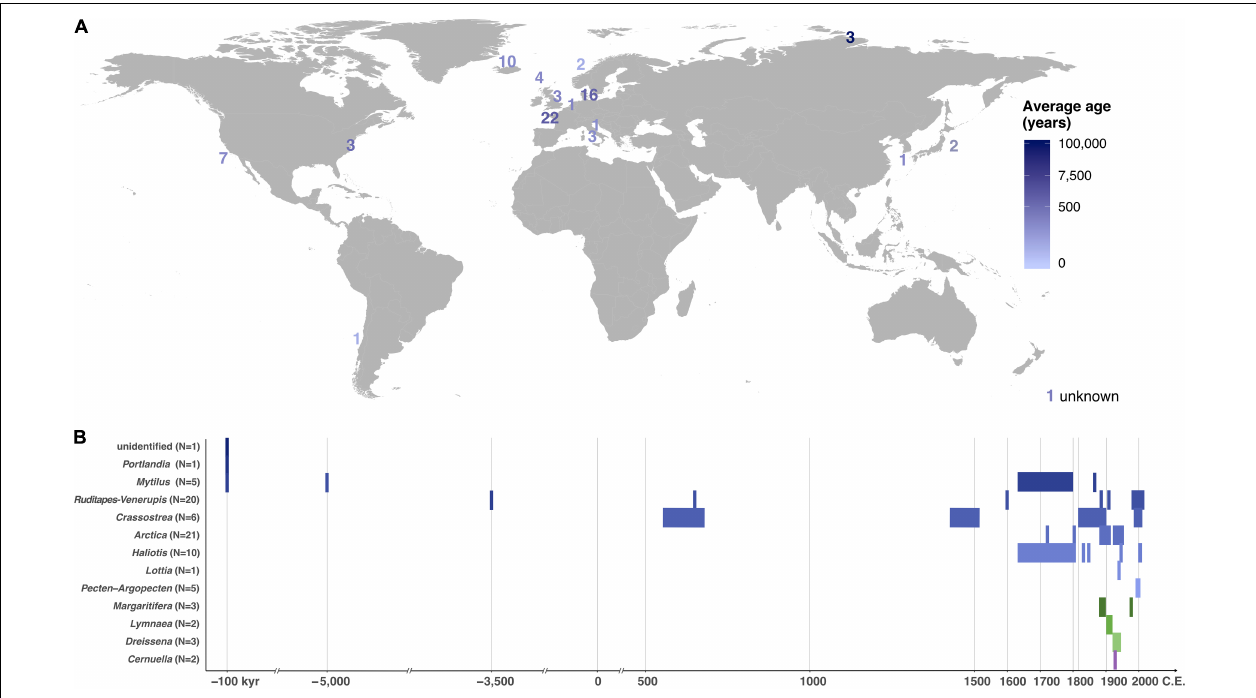
FIGURE 3 | Geographical location and age of the shell samples screened for DNA. (A) Map showing the number and average age of specimens by geographical location. (B) Chronology by genus ( Supplementary Table S1 ). “kyr,” kilo